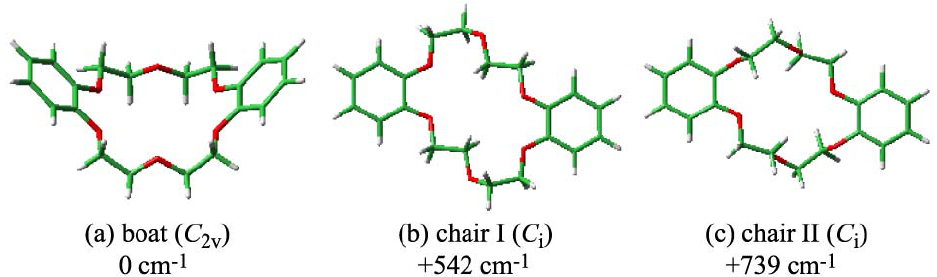
Figure 4. Optimized conformers of DB18C6: (a) boat, (b) chair-I, and (c) chair-II. The numbers shown in cm -1 represent the electronic energies relative to that of the most stable conformer (boat). Figure adapted from Reference